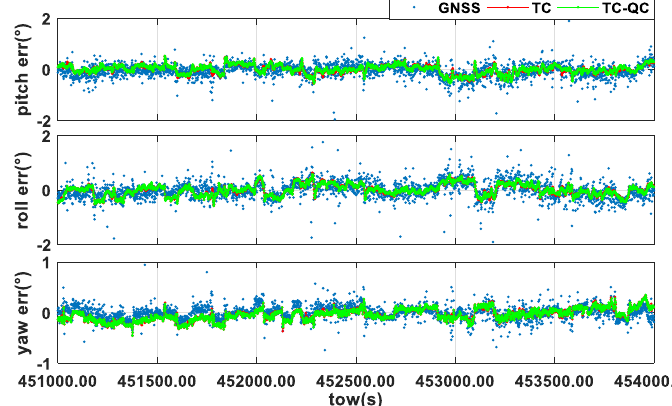
Figure 4. Time sequence of attitude errors. Table 2. Statistics of attitude errors (Unit: degree).